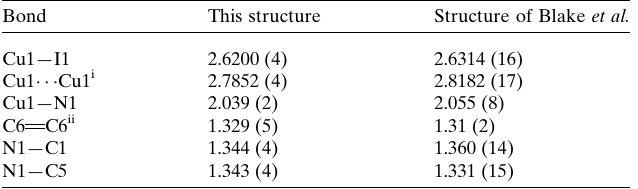
Figure 1 Ellipsoid plot (50% probability level for all non-hydrogen atoms) of the title compound with additional Cu–I fragments included to indicate the directionality of the two-dimensional coordination polymer.